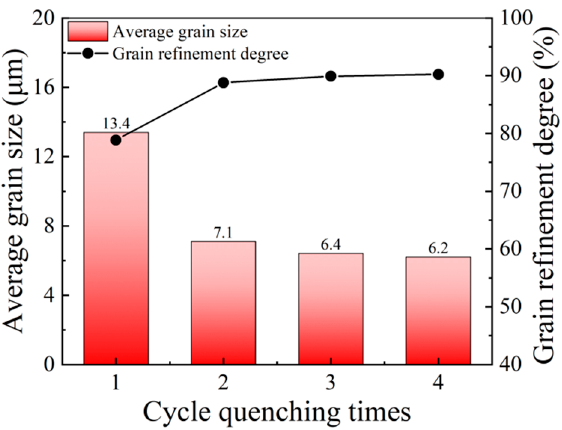
Figure 11. Variations in average grain size and grain refinement degree with cyclic quenching times.